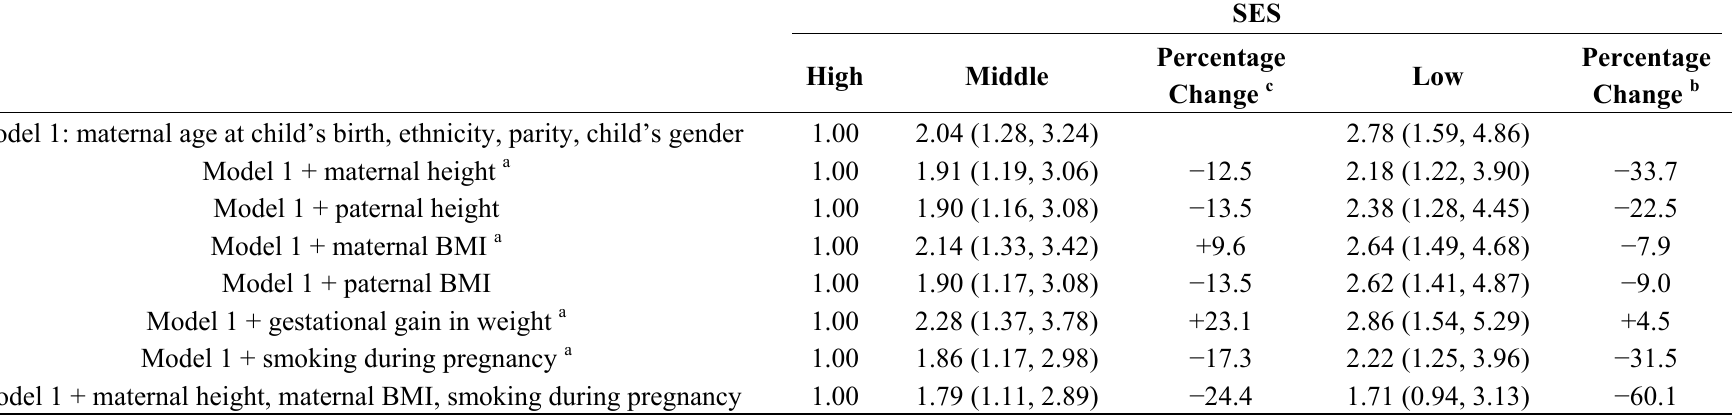
Table 3. Change in the odds ratio (OR) related to levels of socioeconomic status (SES) with low birth weight after separate adjustment for potential